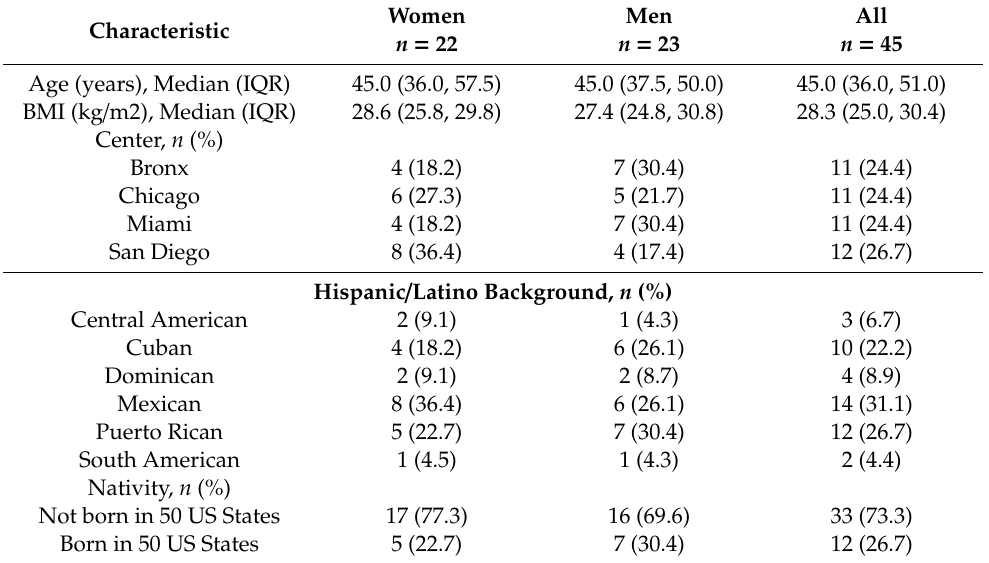
Table 1. Baseline characteristics of the selected pilot sample from the Study of Latinos: Nutrition & Physical Activity Assessment Study (SOLNAS) ancillary study to the Hispanic Community Health Study / Study of Latinos (HCHS /